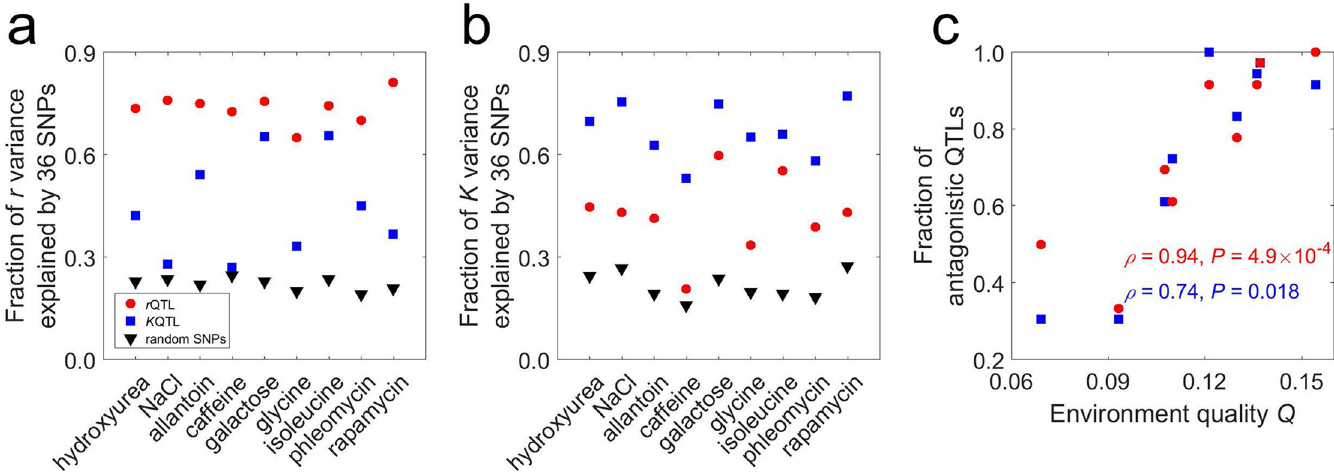
Fig 3. Among-genotype variations of r and K in each environment share genetic components. ( a ) Fractions of r variance among genotypes explainable by 36 r QTLs, 36 K QTLs, and 36 random SNPs, respectively. ( b ) Fractions of K variance among genotypes explainable by 36 r QTLs, 36 K QTLs, and 36 random SNPs, respectively. ( c ) Fractions of r QTLs and K QTLs that show opposite effects on r and K , respectively, increase with environment quality Q . Rank correlations ( ρ ) between these fractions and Q , as well as the associated P -values, are presented. Data are available at https://github.com/AprilWei001/Environment-dependent-r-K-relations. QTL, quantitative trait locus; SNP, single-nucleotide